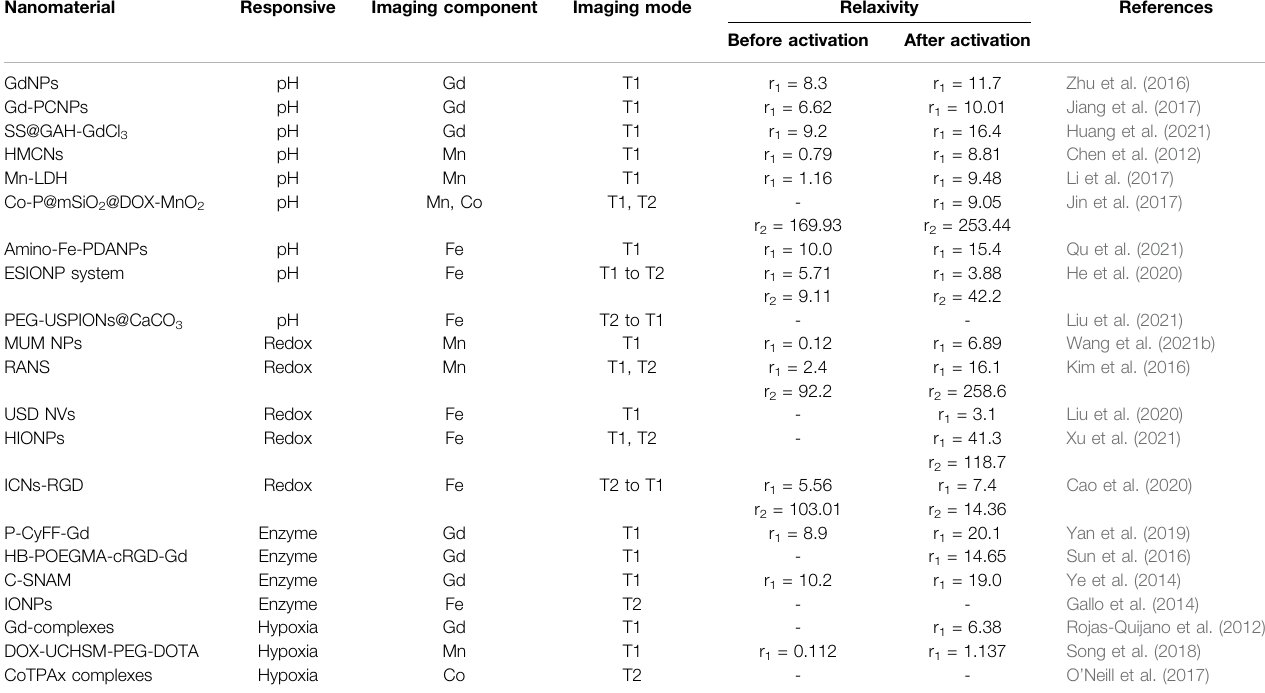
TABLE 1 | Summary of recent work on nanomaterials for TME-responsive MRI.